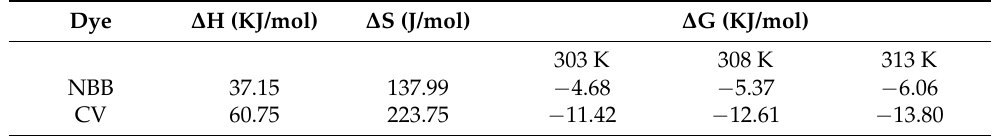
Table 4. Thermodynamic parameters for adsorption of NBB and CV on ACOC.